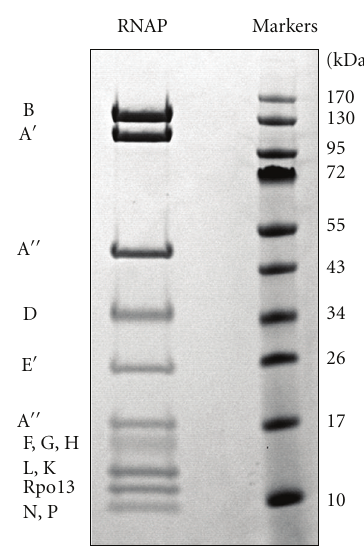
Figure 1: SDS-PAGE showing the purified RNA polymerase from S. solfataricus . In addition to all the expected subunits, a proteolytic product of the A (cid:3)(cid:3) subunit was observed at 17 kDa.